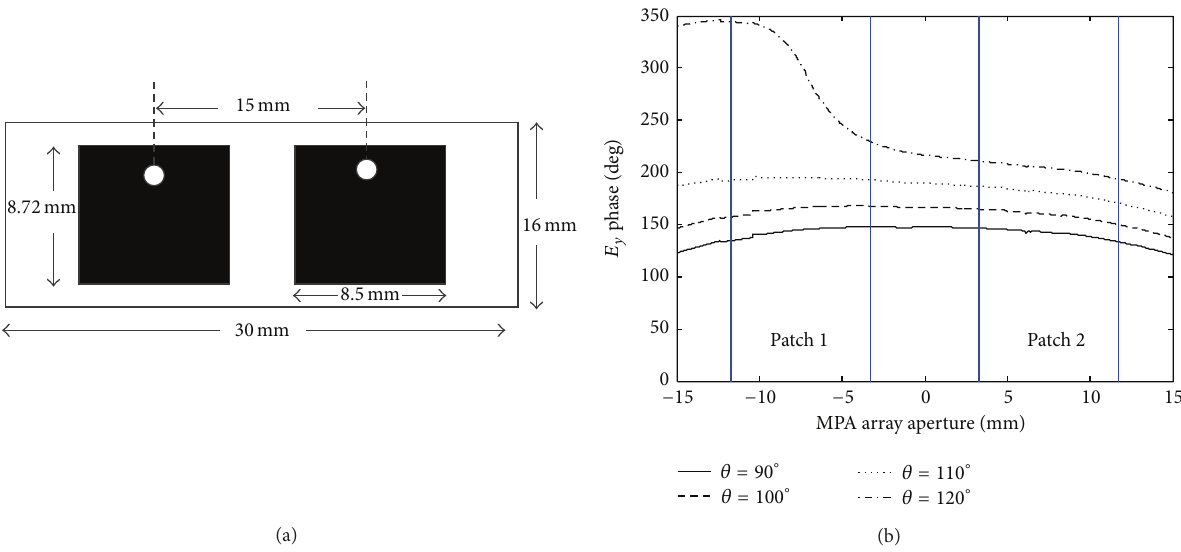
Figure 1: (a) Top view of a 2-patch 0.5 𝜆 PAA operating at 10Ghz, (b) 𝐸 -field phase distribution in the radiated field region of the 2-element PAA for different directions of the main beam.